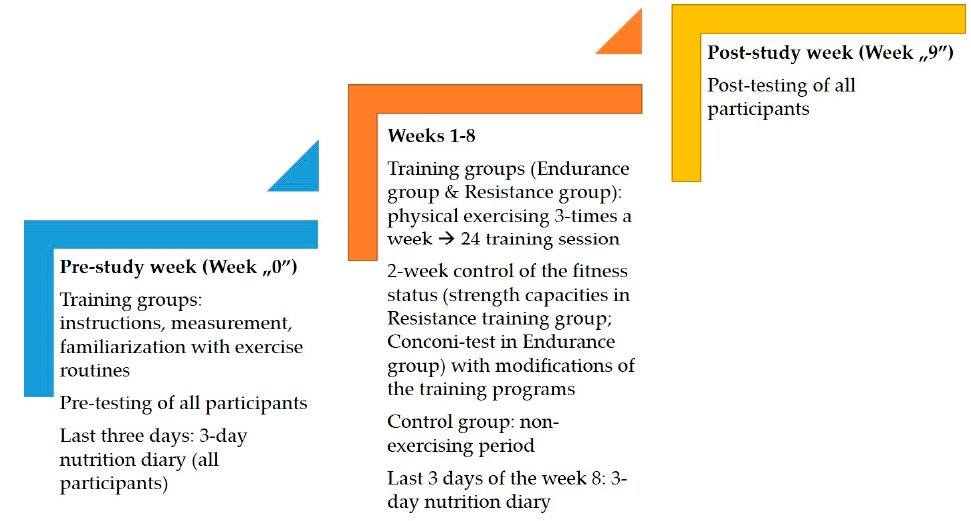
Figure 1. Study design and characteristics of the study phases.